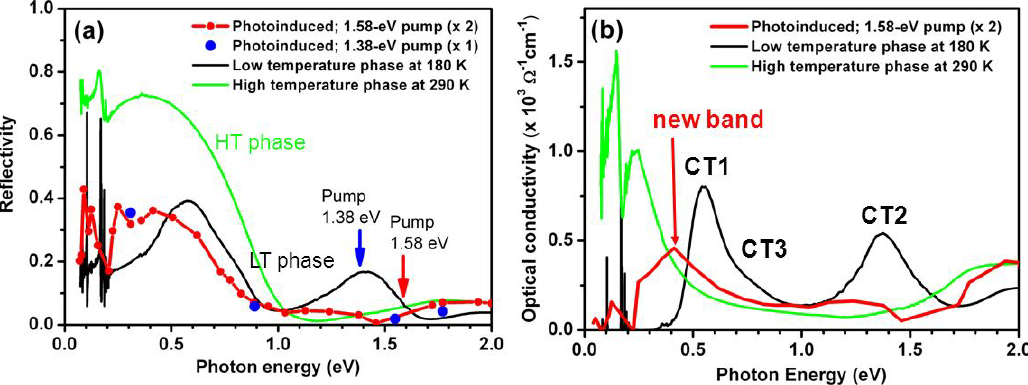
Figure 6. ( a ) Static reflectivity spectra of (EDO-TTF) temperature phases and transient reflectivity spectrum (red) at 0.1 ps after photoexcitation of CT band in low-temperature phase; ( b ) Optical conductivity spectra of (EDO-TTF) derived from reflectivity spectra using the Kramers-Kronig transformation [29].